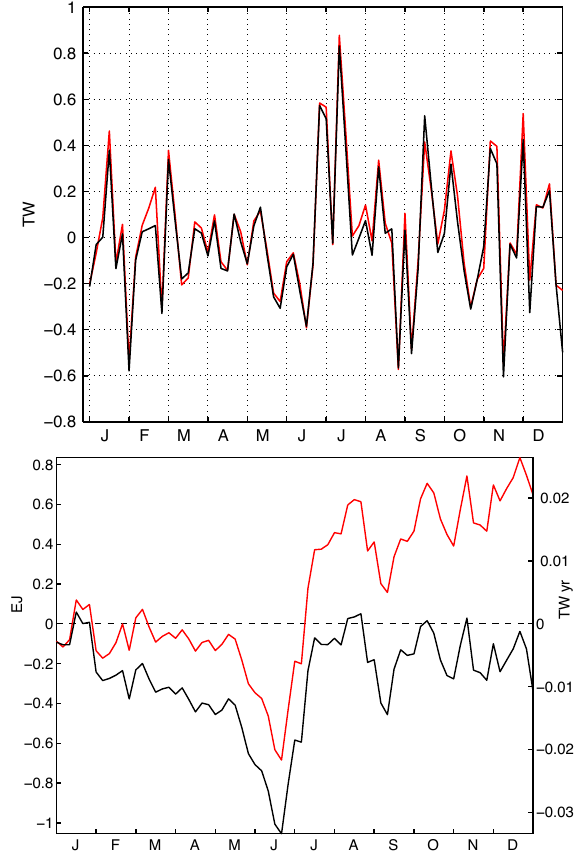
Fig. 3. Results for the single column of model cells at 150 ◦ W, 4.5 ◦ N during model year 1994. (a) Sum of the advection and dif- fusion terms (red – calculated from the 5-day mean datasets) and rate of change of heat content (black – calculated from the instanta- neous datasets). Heat flux in TW (10 12 W). (b) Cumulative integrals of both terms. Heat content in EJ (10 18